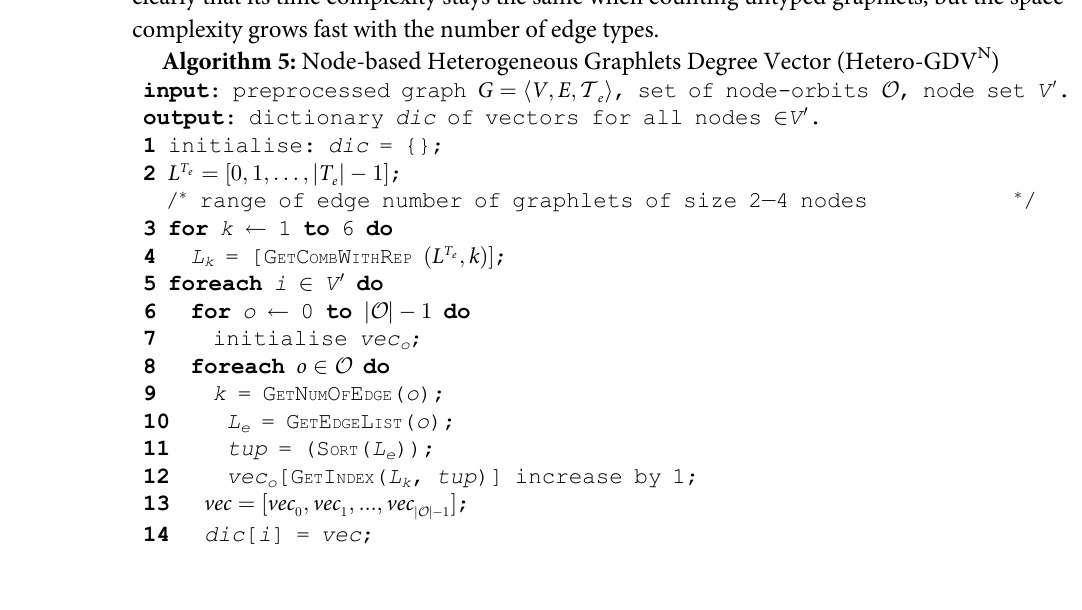
Algorithm 5: Node-based Heterogeneous Graphlets Degree Vector (Hetero-GDV N